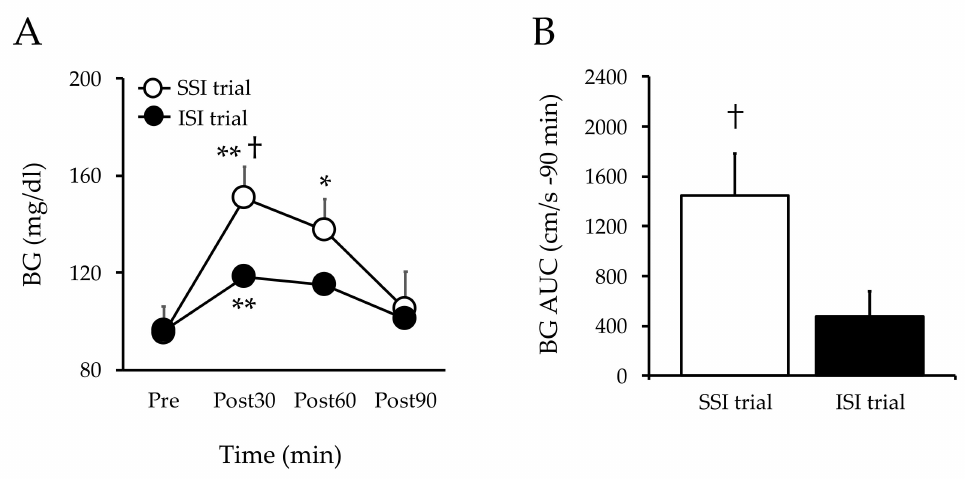
Figure 3. Changes in blood glucose at baseline and post-ingestion in both trials. Values are mean ± SD. ** p < 0.01 and * p < 0.05, vs. baseline. † p < 0.05, vs. ISI. BG, blood glucose; SSI, sucrose solution intake; ISI, isomaltulose solution intake; SD, standard deviation; Figure 3A, blood glucose; Figure 3B, blood glucose AUC.